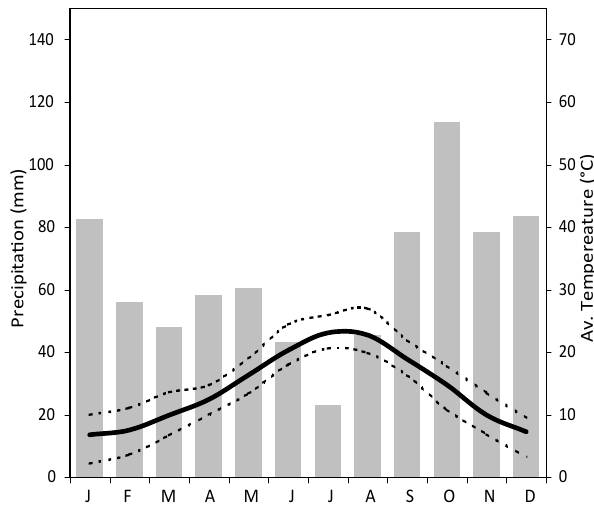
Fig. 1. Yearly average climate diagram of the study area for 1970– 2008. Bars: precipitation, continuous line: average temperature, dashed lines: monthly average minimum and maximum tempera-